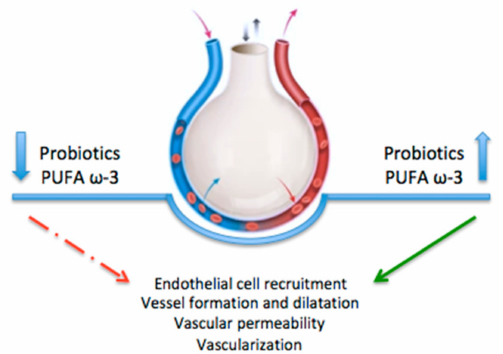
Figure 4. Diet supplementation and vascular development. Supplementation with probiotics and PUFA ω -3 affect endothelial cell recruitment, vessel formation and dilatation, vascular permeability, and